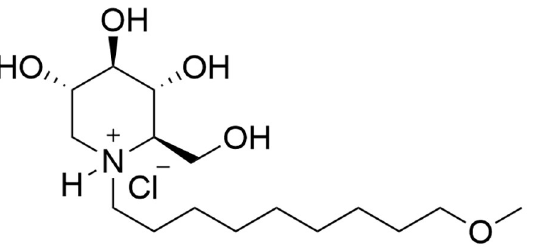
Fig 3. Structural formula of UV-4 Hydrochloride. Chemical structure of N -(9’-methoxynonyl)-1-deoxynojirimycin hydrochloride (UV-4B).